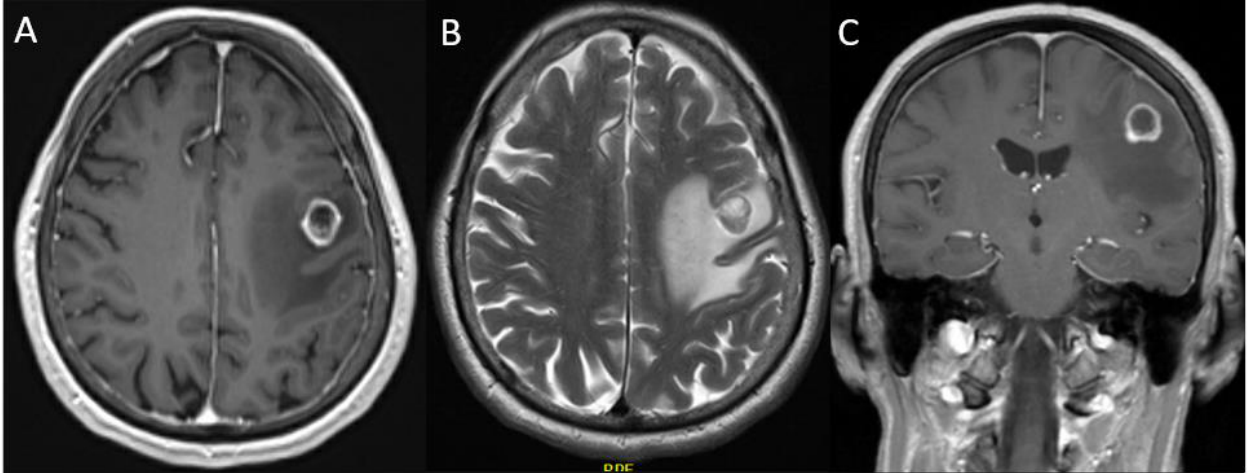
Figure 4. Preoperative MRIs. ( A ): Axial weighted T1 with contrast demonstrating a well circumscribed lesion in the left precentral gyrus with surrounding hypointense signal representing edema. ( B ): T2-Weitghed MRI with a hyperintense, ovoid, well-defined lesion within the left precentral gyrus. Vasogenic edema is visible in this image as a hyperintense signal around the mass. ( C ): Weighted coronal T1 with contrast demonstrating clear visualization of the lesions well-circumscribed margins.